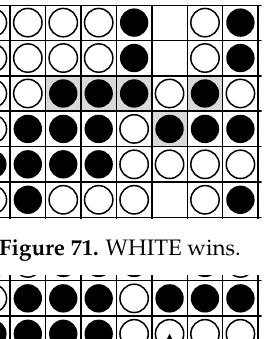
Figure 71. WHITE wins.